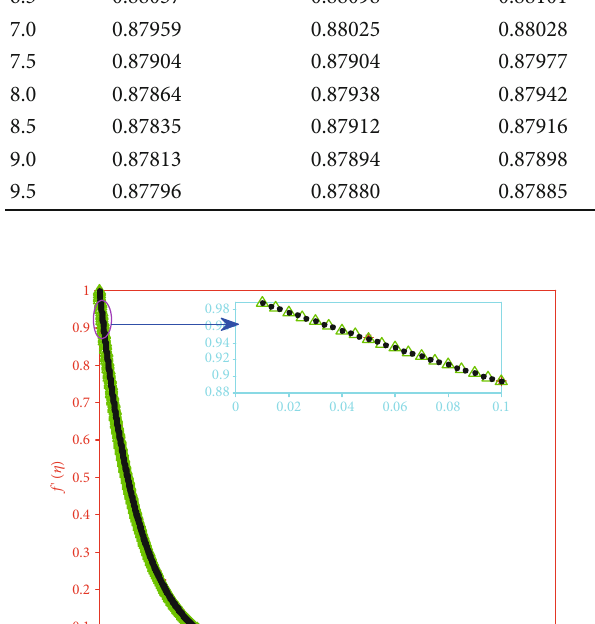
Figure 36: Grid-independence tests showing every fi fth element of the mesh for concentration pro fi